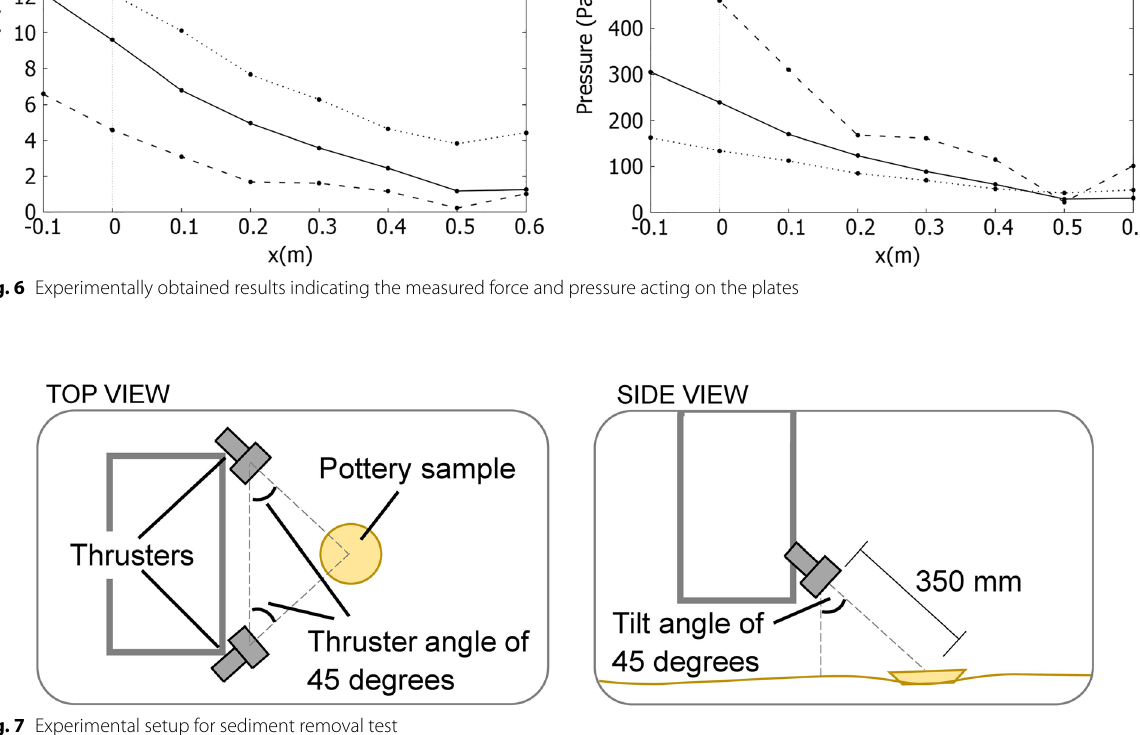
Fig. 7 Experimental setup for sediment removal